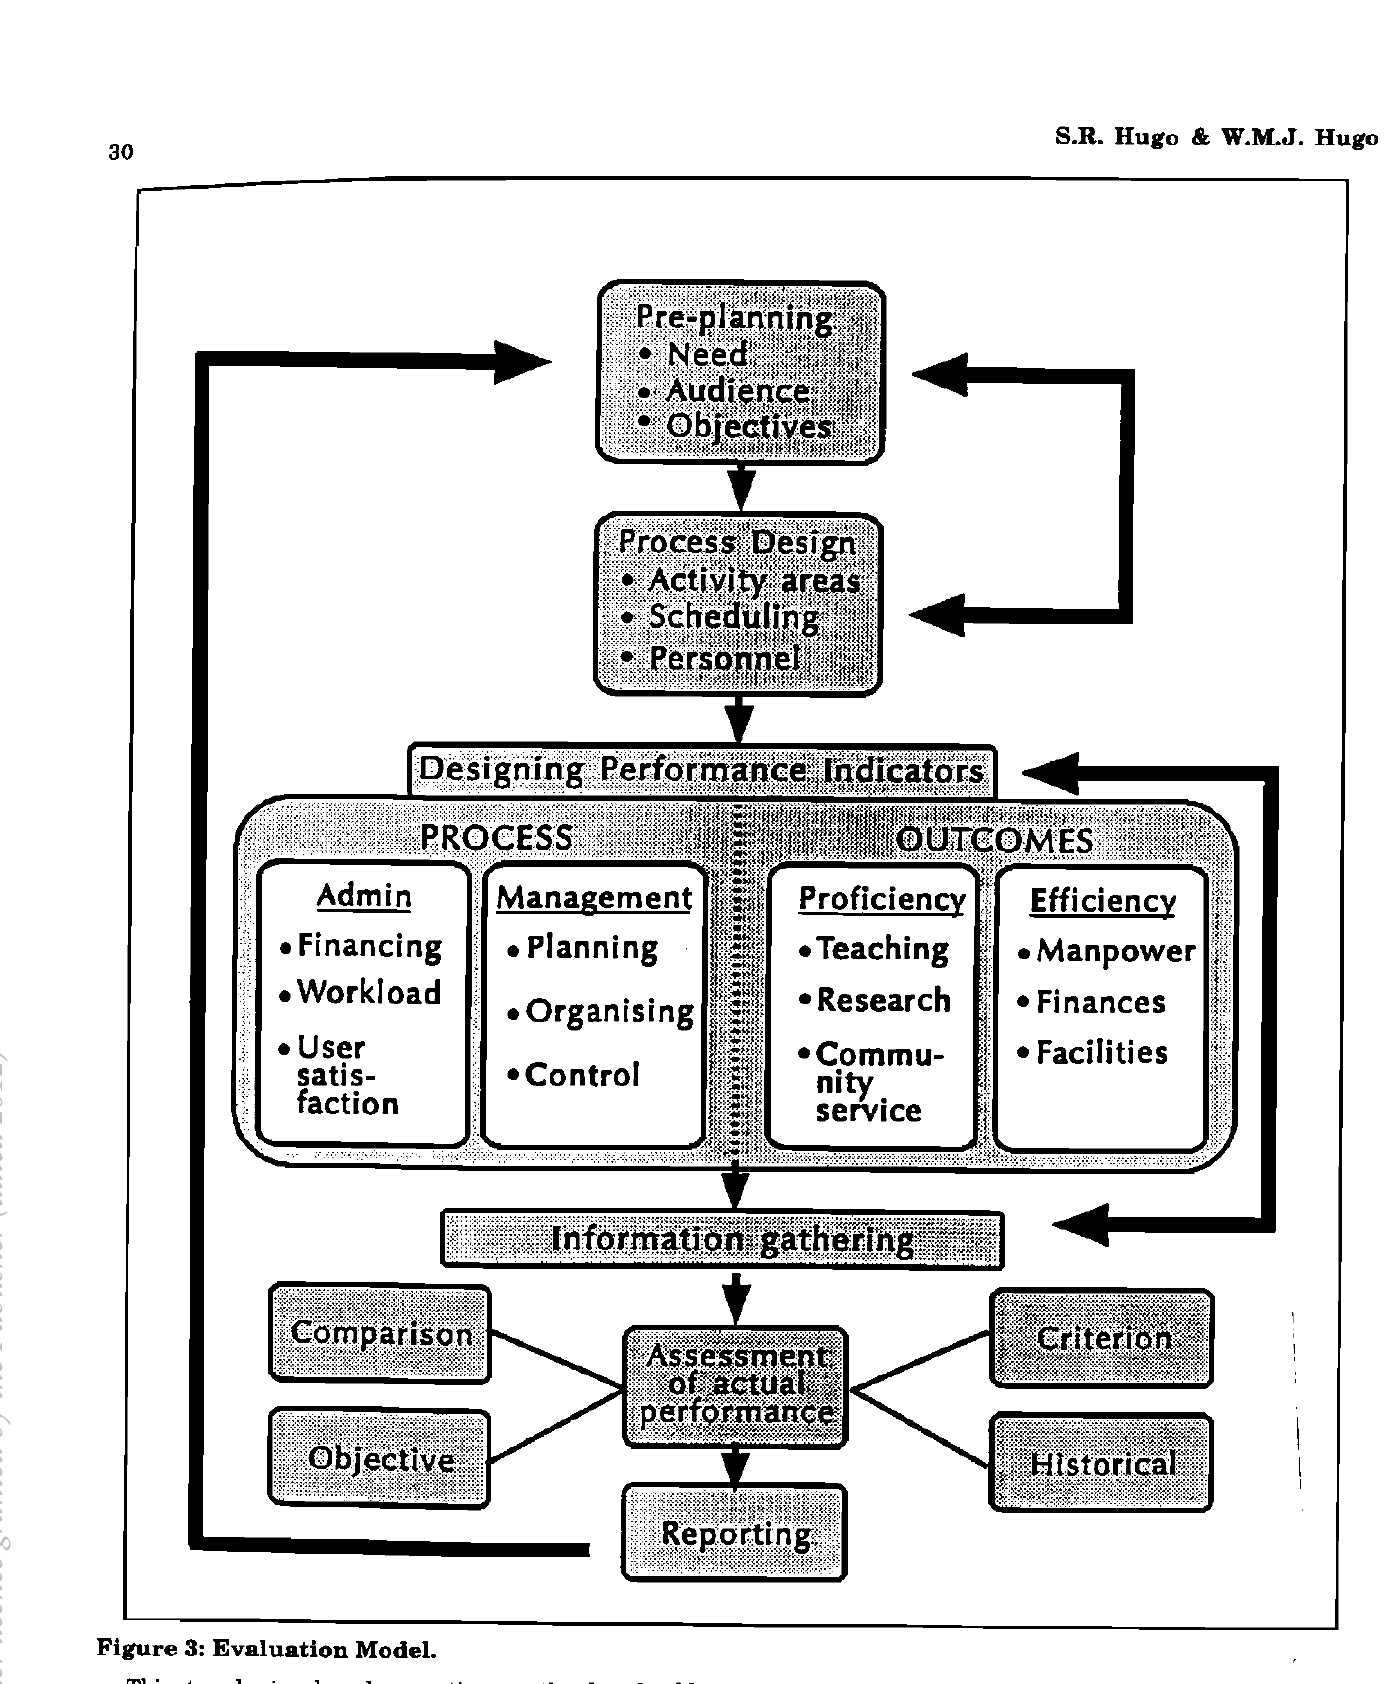
Figure 3: Evaluation